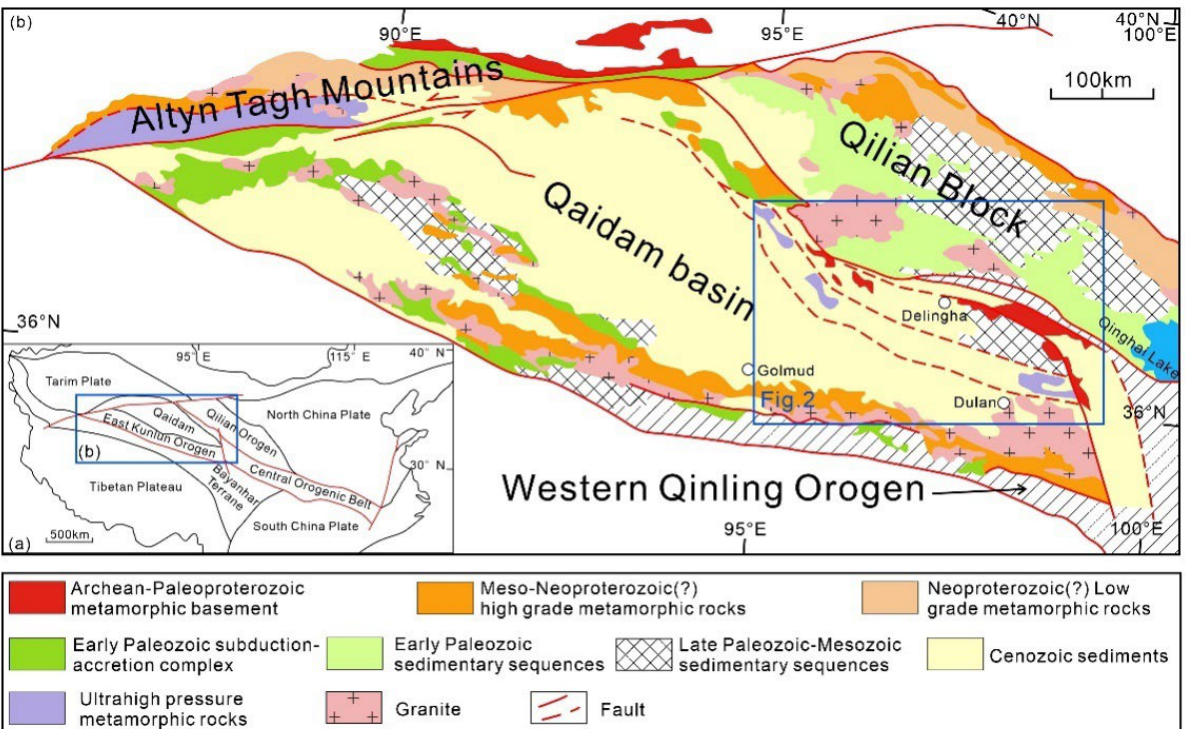
Figure 1. ( a ) Tectonic framework of the Central China Orogen [79]; ( b ) Simplified geological map of the NQ and the surrounding region [14].